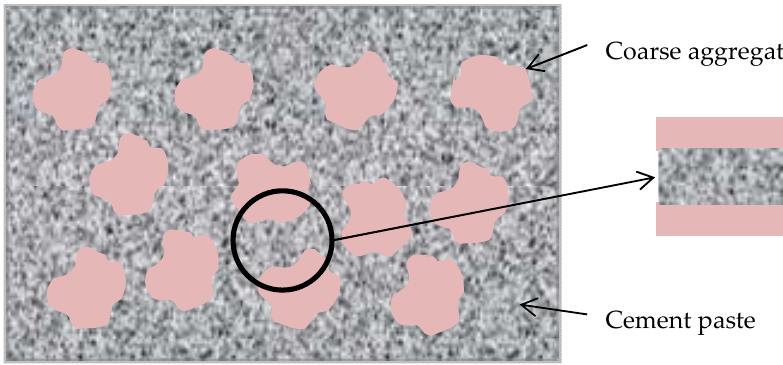
Figure 1. Cement paste flow in concrete is directly influenced by the action of coarse aggregate [4].